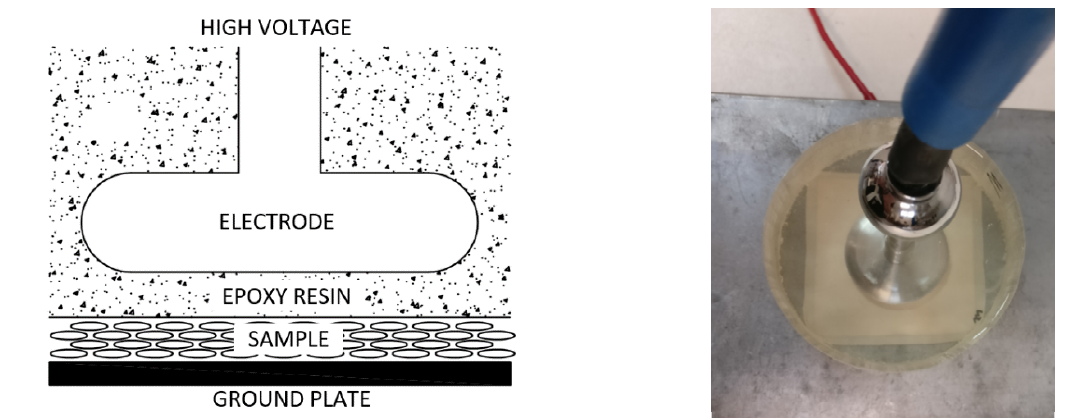
Figure 5. Experimental setup with a dielectric layer of glass and the high-voltage electrode surrounded by oil to avoid surface discharges.